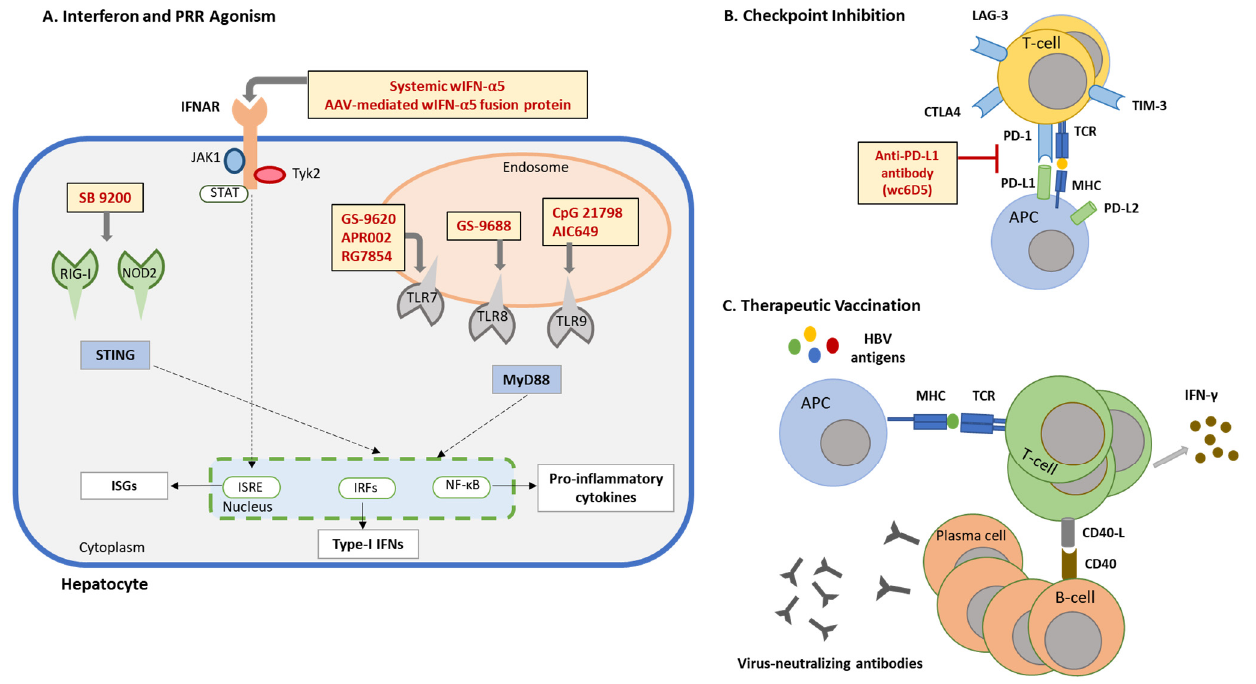
Figure 1. Immunomodulatory strategies recently evaluated in the woodchuck animal model of CHB. Approaches to retrieve the impaired antiviral immune response for the control of chronic HBV infection include ( A ) Interferon and PRR Agonism with IFN- α (systemic wIFN- α 5 and AAV-mediated wIFN- α 5 fusion protein), RIG-I/NOD2 agonist (SB 9200), TLR7 agonists (GS-9620, APR002, and RG7854), TLR8 agonist (GS-9688), and TLR9 agonists (CpG 21798 and AIC649). These compounds activate their receptor downstream signaling pathways via the adaptor molecules STAT, STING, or MyD88 for the induction of type-I IFNs, ISGs, and pro-inflammatory cytokines. Type-I IFNs target the persistent viral cccDNA reservoir in the nuclei of infected hepatocytes. ( B ) Checkpoint Inhibition with anti-PD-L1 antibody (wc6D5). This leads to the blockage of inhibitory PD-1/PD-L1 interaction between T-cells and APCs. ( C ) Therapeutic Vaccination. Protein- or DNA- based vaccines containing or encoding for viral antigens are administered for the priming/activation of antiviral T- and B-cells. T-cells secrete antiviral cytokines, including IFN- γ , and B-cells differentiate into plasma cells and secrete virus-neutralizing antibodies thereafter. See text for details. Abbreviations: AAV, adeno-associated virus; APC, antigen presenting cell; CD40, B-cell surface antigen; CD40-L, CD40 ligand; CTLA4, cytotoxic T-lymphocyte antigen 4; HBV, hepatitis B virus; IFN, interferon; IFNAR, interferon-alpha receptor; IRFs, interferon regulatory factors; ISGs; interferon-stimulated genes; ISRE, interferon-sensitive response element; JAK1, janus kinase 1; LAG-3, lymphocyte-activation gene 3; MHC, major histocompatibility complex; MyD88, myeloid differentiation primary response